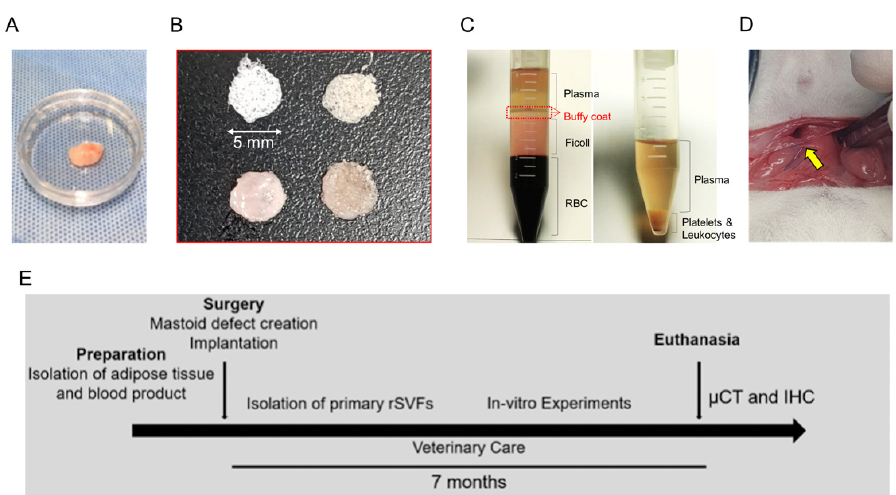
Figure 1. In vivo study design. The experimental composites included ( A ) uncultured stromal cells (fat) in a 35 mm dish, ( B ) PCL scaffold with blood products, and ( C ) blood products for bone reconstruction in mastoid bulla (15 mL conical tube). ( D ) Surgical procedure was performed with an anterior auricular incision with the yellow arrow indicating mastoid bulla defects. ( E ) The overall study schedule of the experiment for mastoid regeneration.